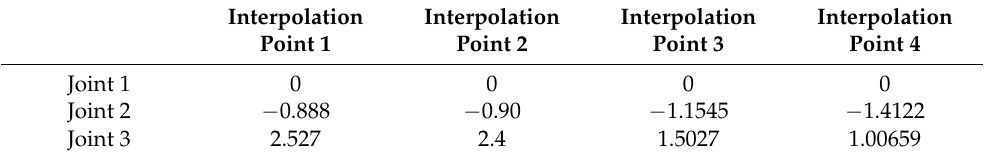
Table 5. Interpolation points selected in the experiment.